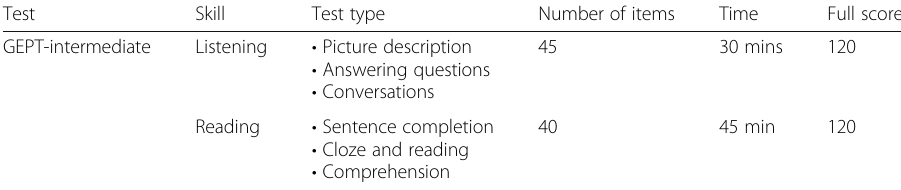
Table 1 GEPT-intermediate: skills, test types, items, time, and scores